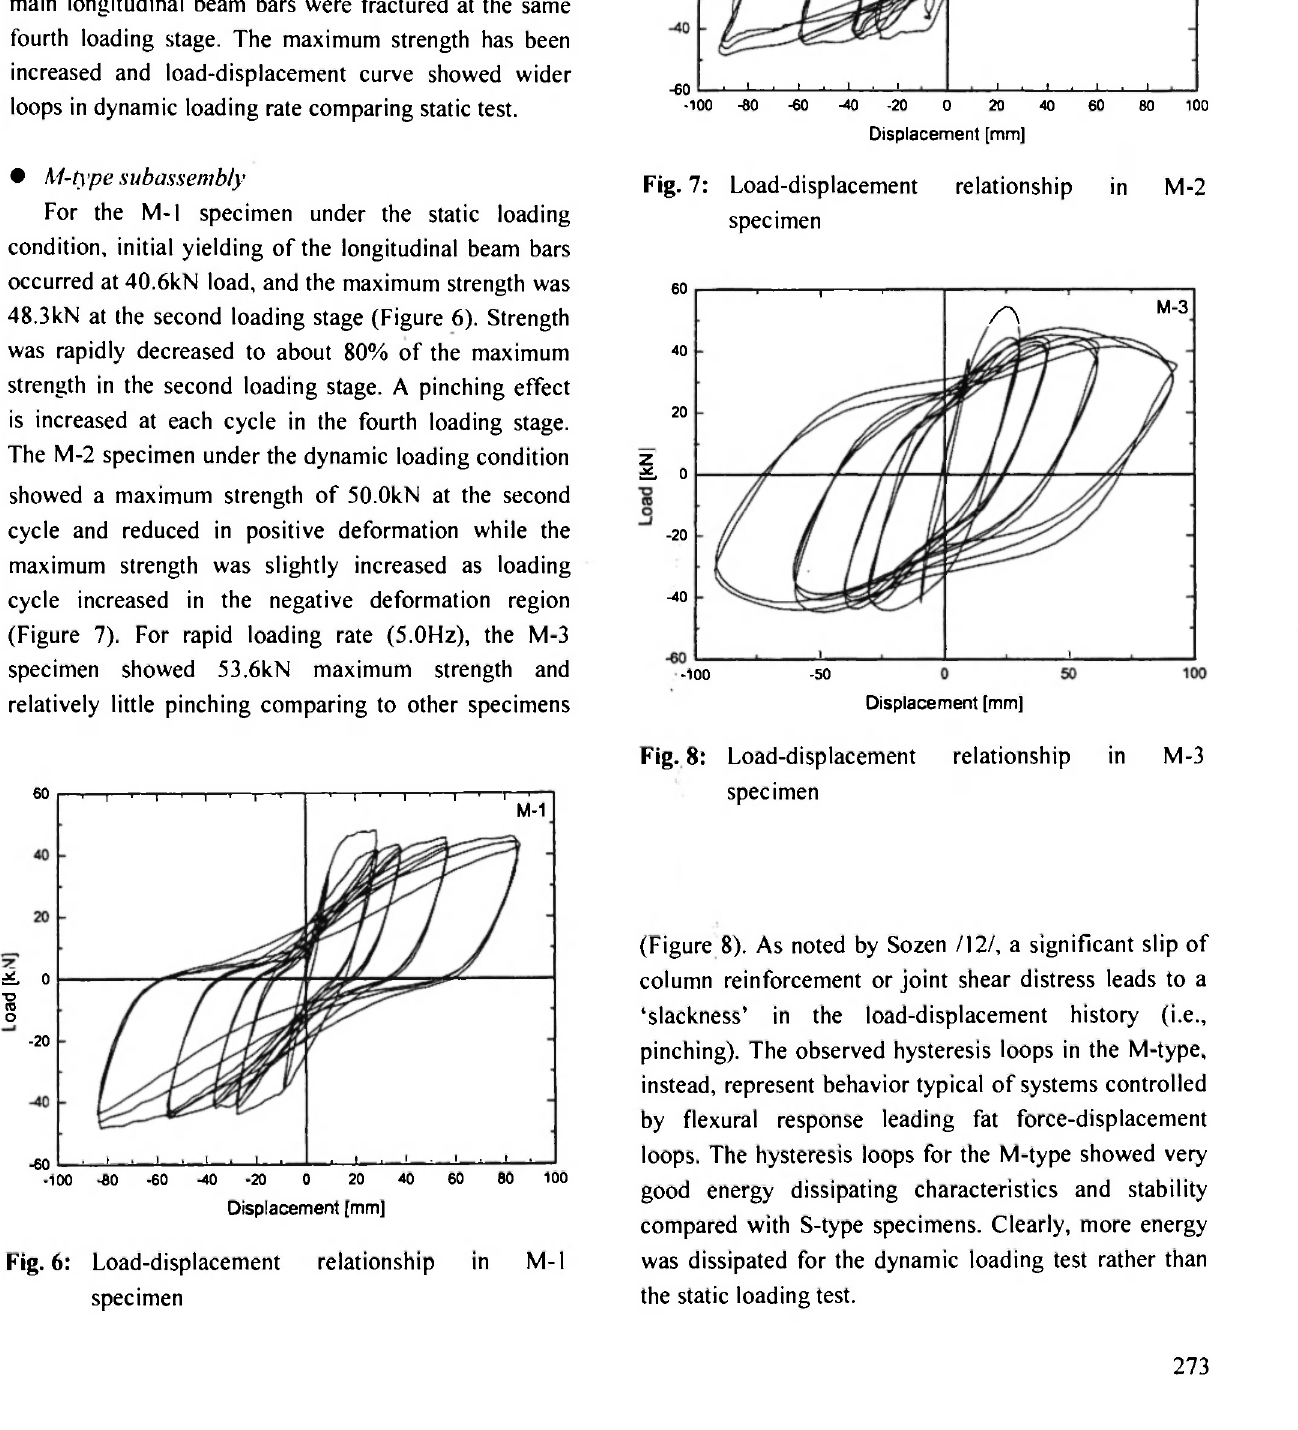
Fig. 6: Load-displacement relationship in M-l specimen